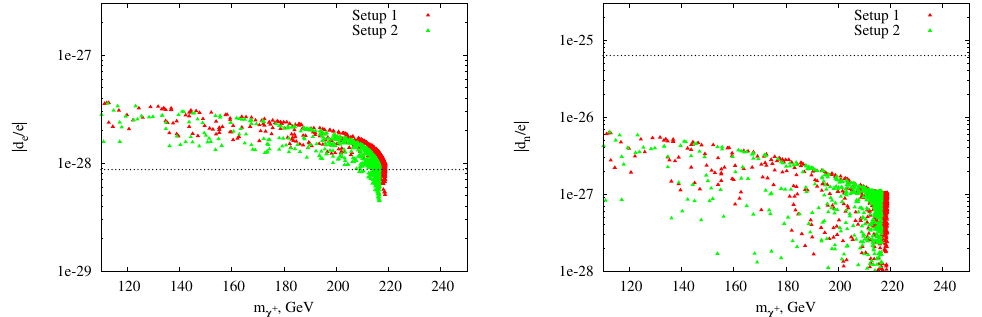
Figure 5 . Left panel: the EDM of electron versus the lightest chargino mass m indicates the current experimental bound j d e =e j < 8 : 7 (cid:2) 10 (cid:0) 29 cm. Right panel: the same for the neutron’s EDM with current upper limit j d n =e j < 3 : 0 (cid:2) 10 (cid:0) 26 cm. The relevant parameters are given in tables 1 and